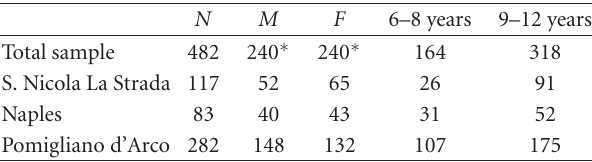
Table 1: Demographic characteristics of the